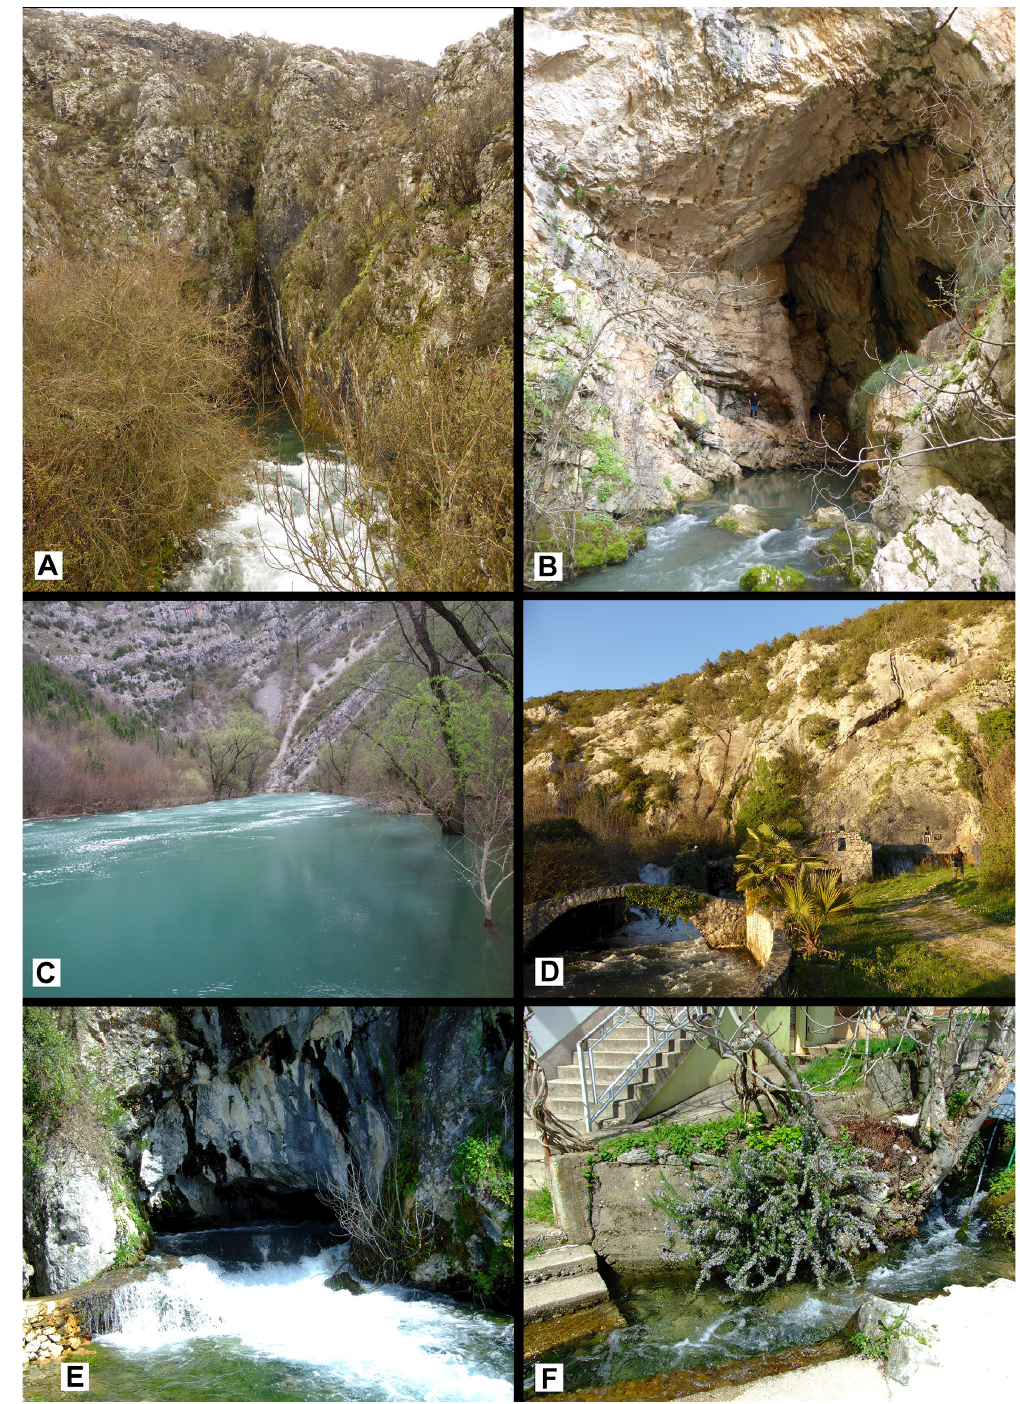
Fig. 3. Photos of studied localities in Hercegovina. A . Dabarsko Polje, Sušicka Peć cave near spring Vrijeka (LT of Plagigeyeria reischuetzorum sp. nov. and Travunijana gloeri sp. nov.). B . Tihaljina, spring Tihaljina in Peć Mlini Cave ( Belgrandia torifera Schütt, 1961). C . Hodbina, spring Bunica (likely LT of P. mostarensis Kuščer, 1933 , P. ovalis Kuščer, 1933). D . Studenci, spring Kajtazovina (LT of P. olsavskyi sp. nov.) E . Vitina, spring Vrioštica (LT of P. vriosticaensis sp. nov. and P. ozimeci sp. nov.) F . Lukende, Jakšenica, Vrelo Jakšenica (LT of P. angyaldorkae sp. nov.) Photos: Jozef Grego, Dorottya Angyal and Mário